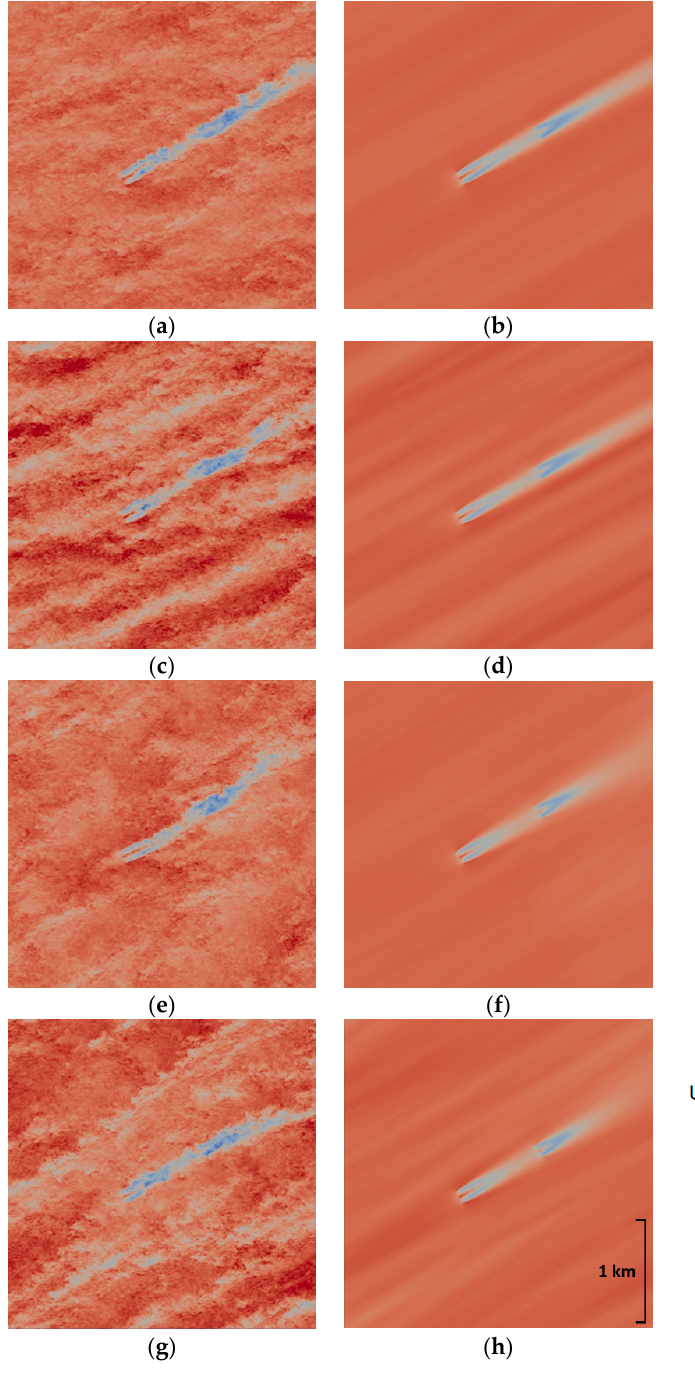
Figure 4. Top view of the instantaneous ( a , c , e , g ) and time-averaged ( b , d , f , h ) streamwise velocities for NLABL, NHABL, ULABL, and UHABL (refer to Table 1) at hub-height (Z = 90 m).